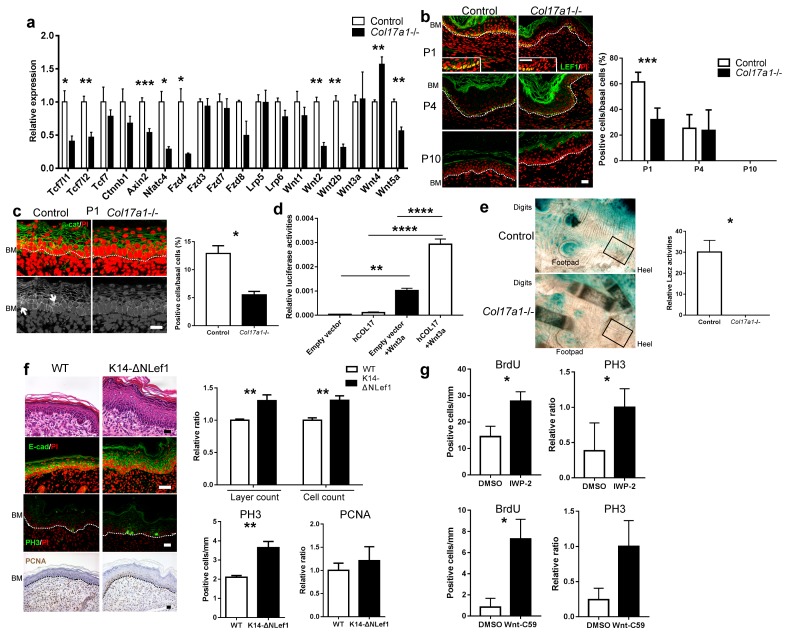
COL17 deficiency destabilizes Wnt-β-catenin signaling in neonates.(a) qRT-PCR of Wnt-related molecules in Col17a1−/− and control IFE skin samples at P1 (n = 5). Student’s t-test. (b) LEF1 staining of Col17a1−/− and control IFE skin at P1 (n = 5), P4 (n = 4) and P10 (n = 4). Inlet: higher magnification of LEF1-positive basal cells at P1. Scale bar: 20 μm. Quantitation of LEF1-positive basal cells as a percentage of all basal cells (%). Student’s t-test. (c) β-catenin staining of Col17a1−/− and control IFE skin at P1. Nuclear β-catenin accumulation is indicated with arrows. The quantification of nuclear β-catenin-positive cells (n = 3). Student’s t-test. Scale bar: 20 μm. (d) Wnt activity in STF293 cells expressing hCOL17 treated with Wnt3a CM (n = 3). One-way ANOVA test, followed by Tukey’s test. (e) Wnt activities in the hindpaw IFE from ins-Topgal+ (Control: left) and ins-Topgal+:Col17a1−/− (Col17a1−/−: right) mice. Calculated areas devoid of hair follicles or sweat glands are indicated with squares in the representative figures. The results are quantified as the Wnt-activated area per unit (n = 4). Scale bar: 100 μm. Mann-Whitney test. (f) H&E, E-cad, PH3 and PCNA staining of IFE skin samples from K14-ΔNLef and littermate controls at P1. Scale bar: 20 μm. The numbers of epidermal layers, epidermal cell counts and PCNA- and PH3-positive basal cells (n = 4). Student’s t-test. (g) Quantification of BrdU- and PH3-positive cells in WT paw skin IFE treated with Wnt inhibitors (IWP-2 (n = 6) vs DMSO (n = 5) or Wnt-C59 (n = 6) vs DMSO (n = 4)). The data are presented as the means ± SE. Student’s t-test. *0.01<p<0.05, **0.001<p<0.01, ***0.0001<p<0.001, ****p<0.0001.